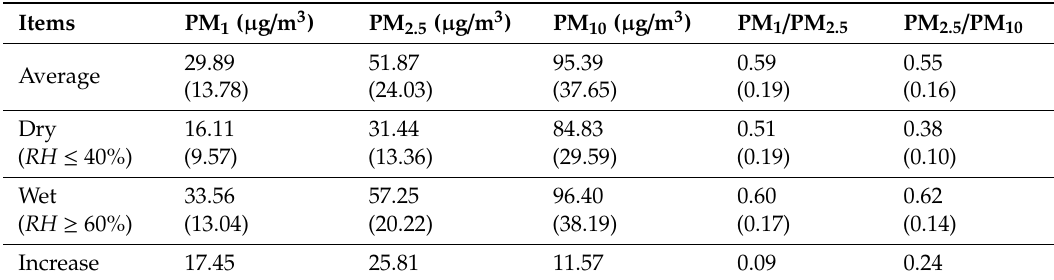
Table 1. Variation statistics of particles under dry and wet conditions.